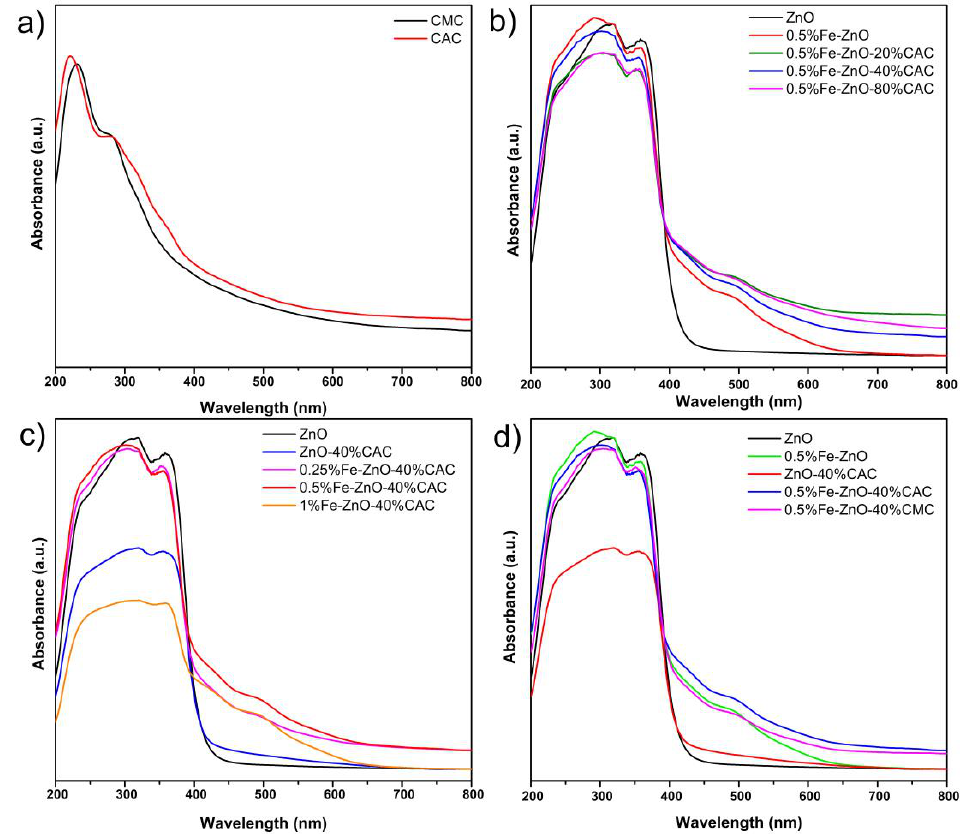
Figure 1. UV−vis diffuse reflectance spectra of the ( a ) purchased microcrystalline cellulose (CMC) and their citric acid modification (CAC); ( b ) composites with different CAC content; ( c ) composites with different Fe content; ( d ) composites with 0.5% Fe and/or 40% CAC. Table 1. Average crystallite size, lattice parameters (a = b (Å), c (Å), c/a ratio) and energy bandgap for hybrids from the series